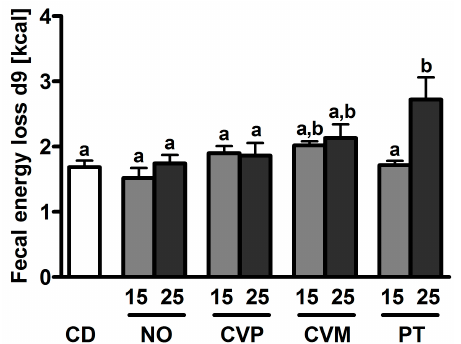
Figure 2. Energy content of feces from female C57BL/6 mice after 9 days of microalgae supplementation or control diet (CD). The following microalgae were supplemented: N. oceanica (NO), C. vulgaris phototrophic cultured (CVP), C. vulgaris mixotrophic cultured (CVM), P. tricornutum (PT). 15 and 25 represent the isocaloric percentage supplementation (wt %) of the according microalgae to the feed of mice. Data are expressed as means ± SEM ( n = 6). Different letters mark significant differences (ANOVA followed by Tukey’s post hoc test; p <